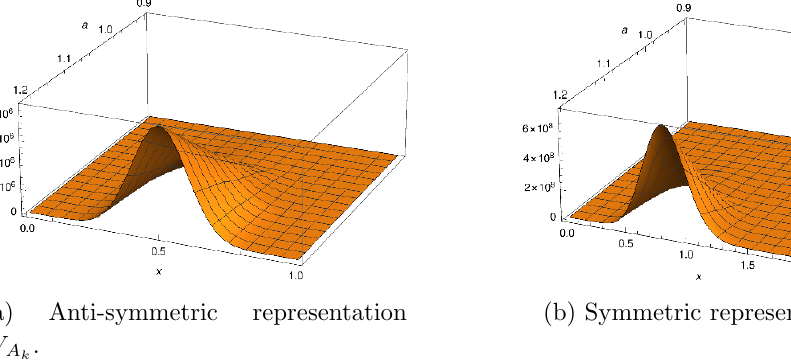
Figure 17. Plot of the expectation value of Wilson loops in (a) the anti-symmetric representation and (b) the symmetric representation, as functions of a and x = k=N for N = 30.